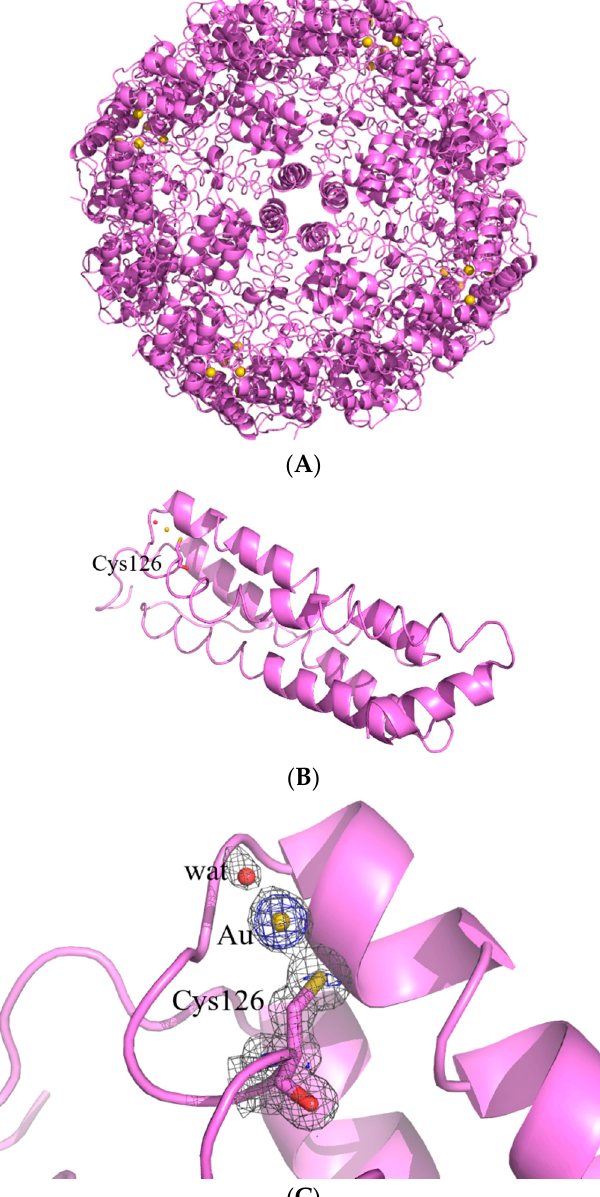
Figure 5. Cartoon representation of the structure of the cage ( A ) and of the single protein chain ( B ) of AF hsFt. The gold binding site is shown in panel ( C ), and 2Fo–Fc and anomalous electron density maps are contoured at 1.0 σ (grey) and 3.0 σ (blue).